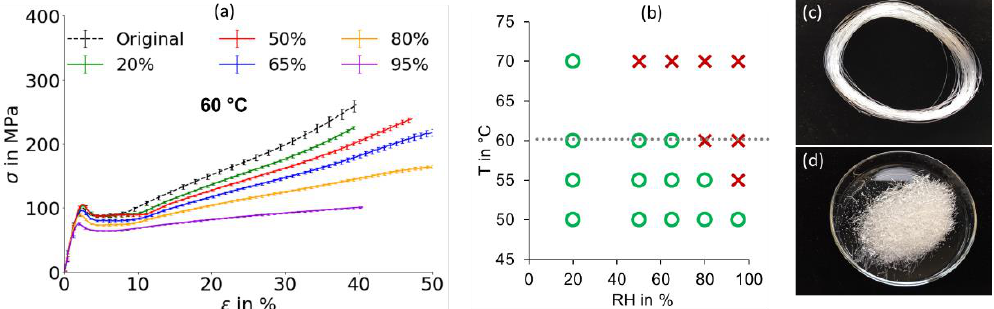
Figure 1. ( a ) Stress–strain curves of monofilaments subjected to artificial aging at 60 ◦ C and indicated relative humidity (%) for two weeks. ( b ) Diagram of stability in terms of RH and aging temperature showing conditions which correspond to mechanically stable (green circles) and mechanically weakened/degraded (red crosses) samples after two weeks of treatment. The dashed line indicates the samples displayed in ( a ). ( c , d ) Images of mechanically intact and completely degraded monofilaments, respectively. The latter was treated under 70 ◦ C and 95% RH for two weeks. Reprinted with adoptions from Ref [29].